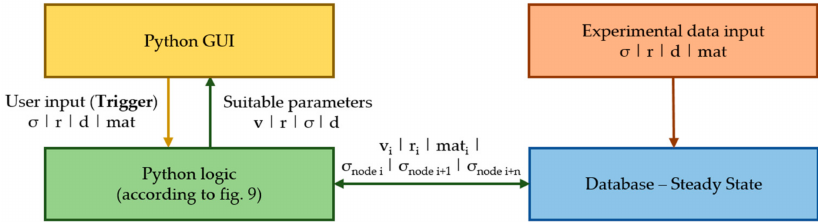
Figure 12. Interaction between the developed residual stress algorithm and GUI. To avoid confusion of respective users, the input of experimental data from practical experiments is excluded from this visualization.